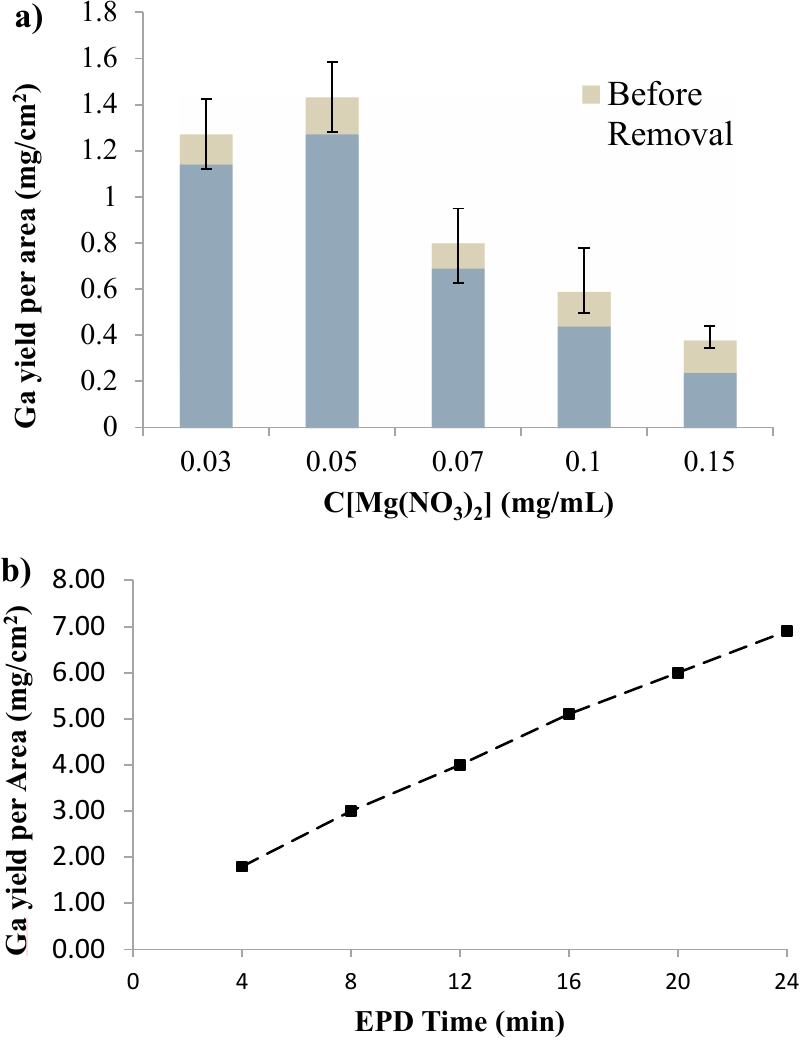
Figure 3. ( a ) The deposition yield as related to different concentration of Mg(NO 3 ) 2 . Deposition time: 4 min; ( b ) Sequential deposition to increase film thickness. Electric field strength: 600 V/cm; concentration of Mg(NO 3 ) 2 : 0.05 mg/mL; Concentration of gallium: 0.5 mg/mL; Temperature: − 15 °